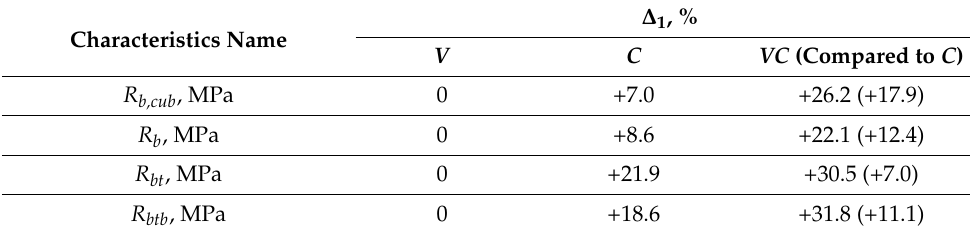
Table 6. Difference in values ( ∆ 1 ) of integral strength characteristics between vibrated, centrifuged, and vibrocentrifuged